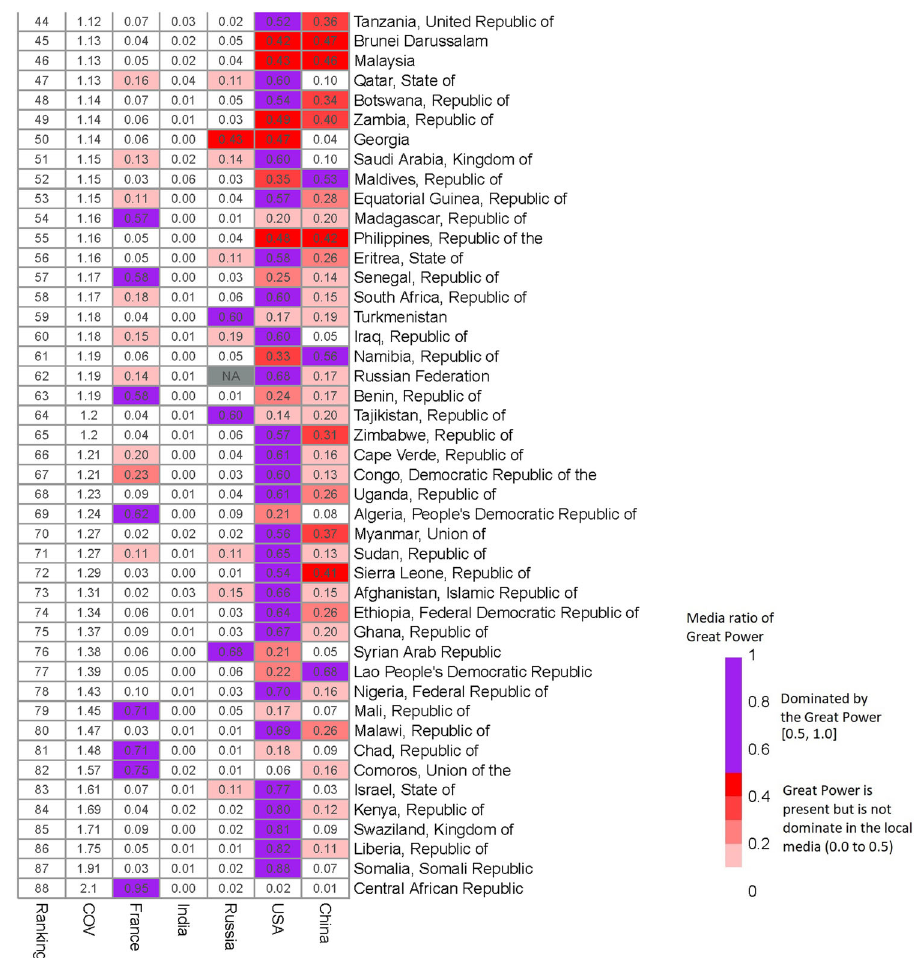
Fig. 2 Coef fi cient of variance and media ratio for great powers for the least competitive countries in Asia and Africa (ranking 44 to 88 out of 88